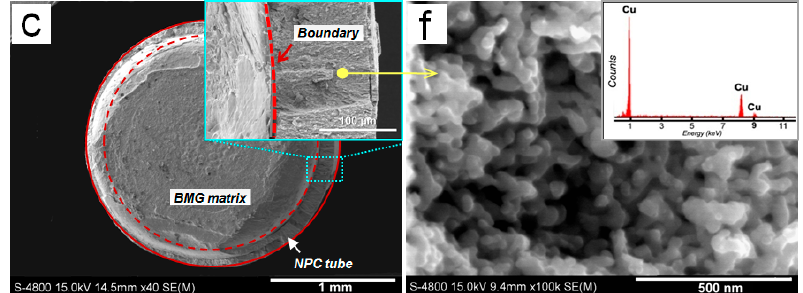
Figure 3. ( a – c ) The section views of the nanoporous copper (NPC)/BMG composite rod 1, 2, and 3, respectively; ( d – f ) High magnification SEM images with their corresponding EDS spectra taken from the same place (about 60 μ m away from the NPC surface).